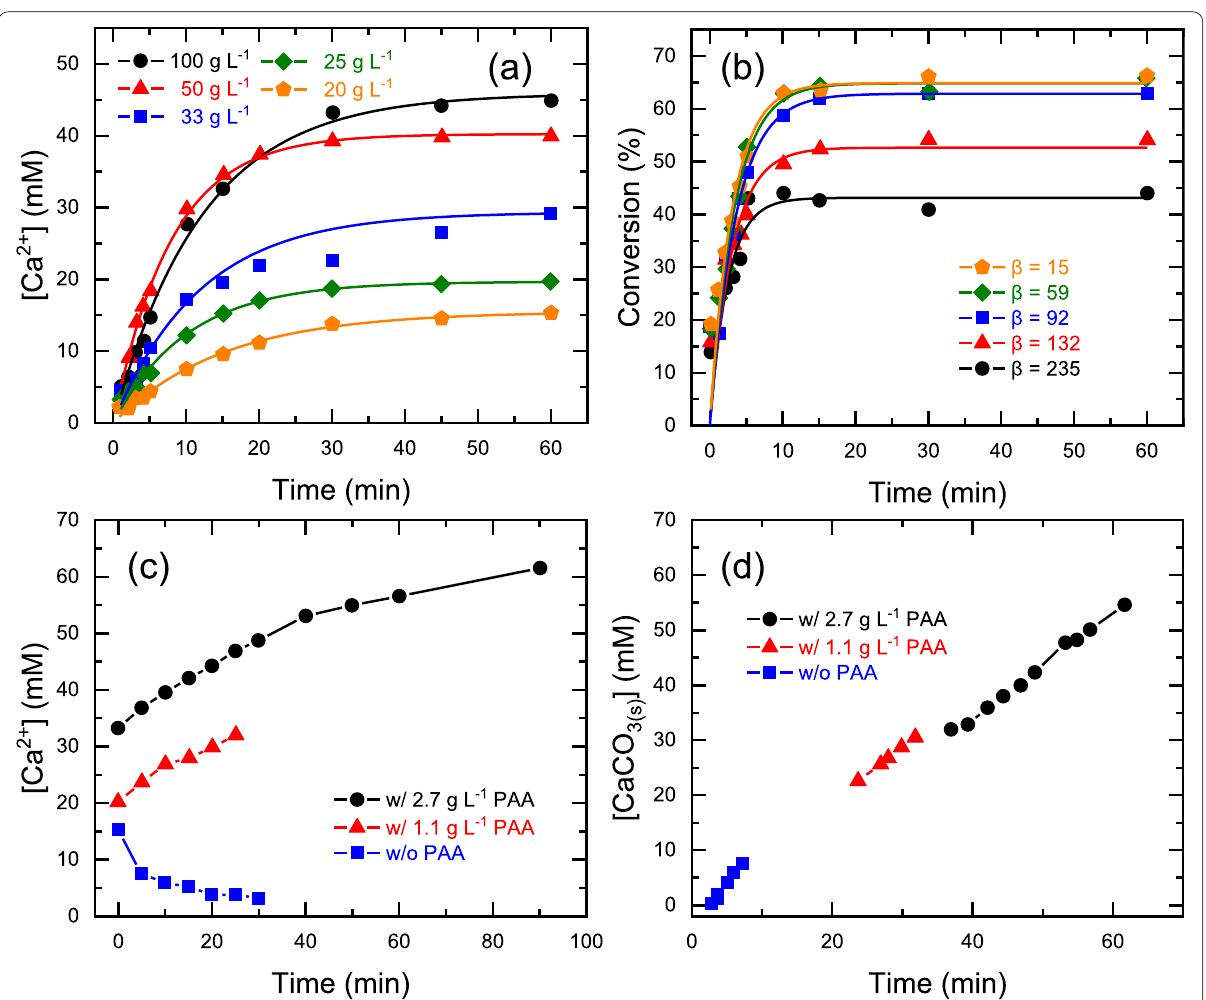
Fig. 8 a Dissolution of calcium from steel slag by cold rolling wastewater as a function of liquid‑to‑solid ratio (LSR) and b its carbonation conversion in rotating packed‑bed reactor with various gravity factor (Reproduced from with permission from [82]. Copyright 2020 American Chemical Society). Effect of polyacrylic acid on c dissolution behavior of waste gypsum and d amount of pure calcium carbonate formation (Reproduced from [84] with permission from